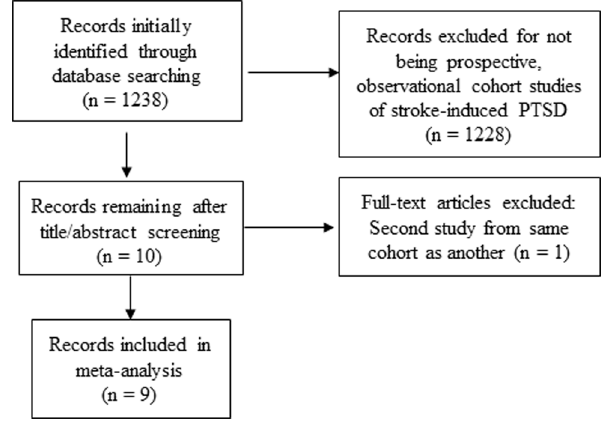
Figure 1. Search strategy flowchart. doi:10.1371/journal.pone.0066435.g001 PLOS ONE |